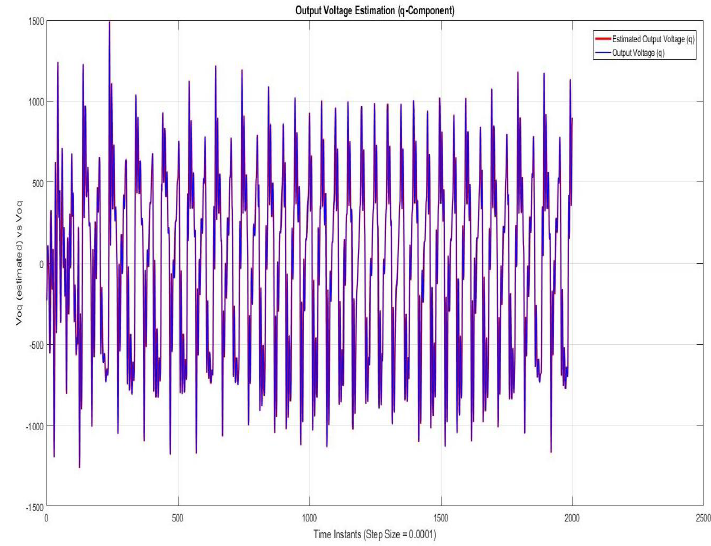
Figure 6. Fault diagnostic observer based state output voltage estimation (q-component). Figure 7 is showing the state/output estimation error using the modified method of determination of SMO gains. The state estimation error can be considered as a performance index for working of state/output estimator SMO, which also acts as fault detection filter. In the fault magnitude of 10 A/100 V the index stays within a controlled range effectively 1 V/0.5 A, with a negligible small mean value.